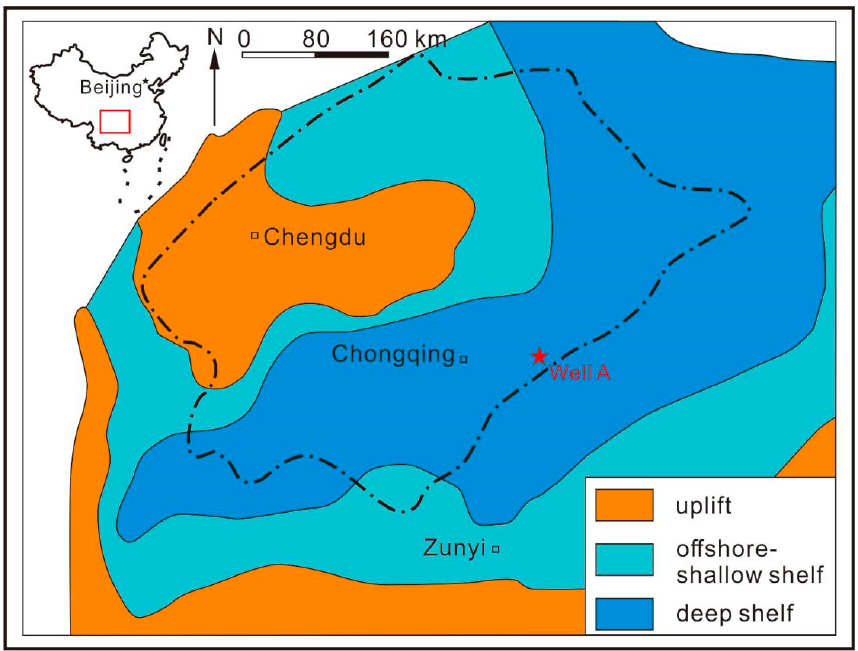
Figure 1. Simplified paleogeographic map of South China during the Ordovician–Silurian transi- tion [27].